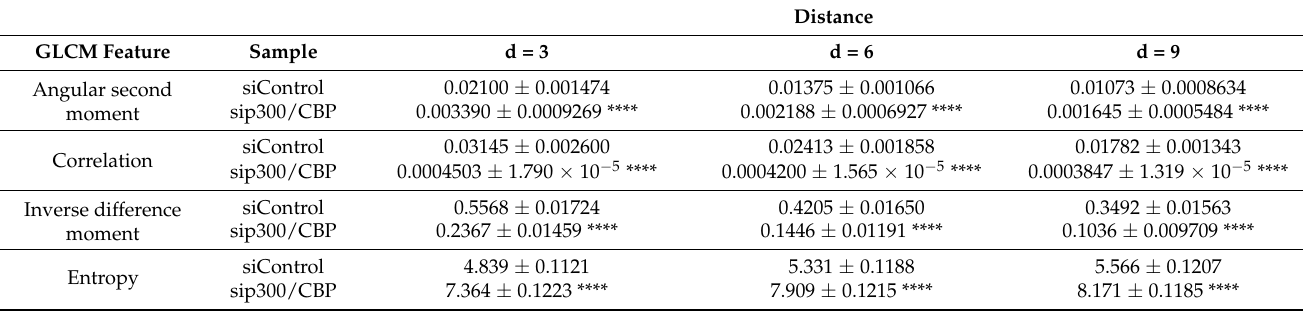
Table 1. Texture analysis of XPG immunofluorescence distribution after siRNA-mediated depletion of p300 and CBP.